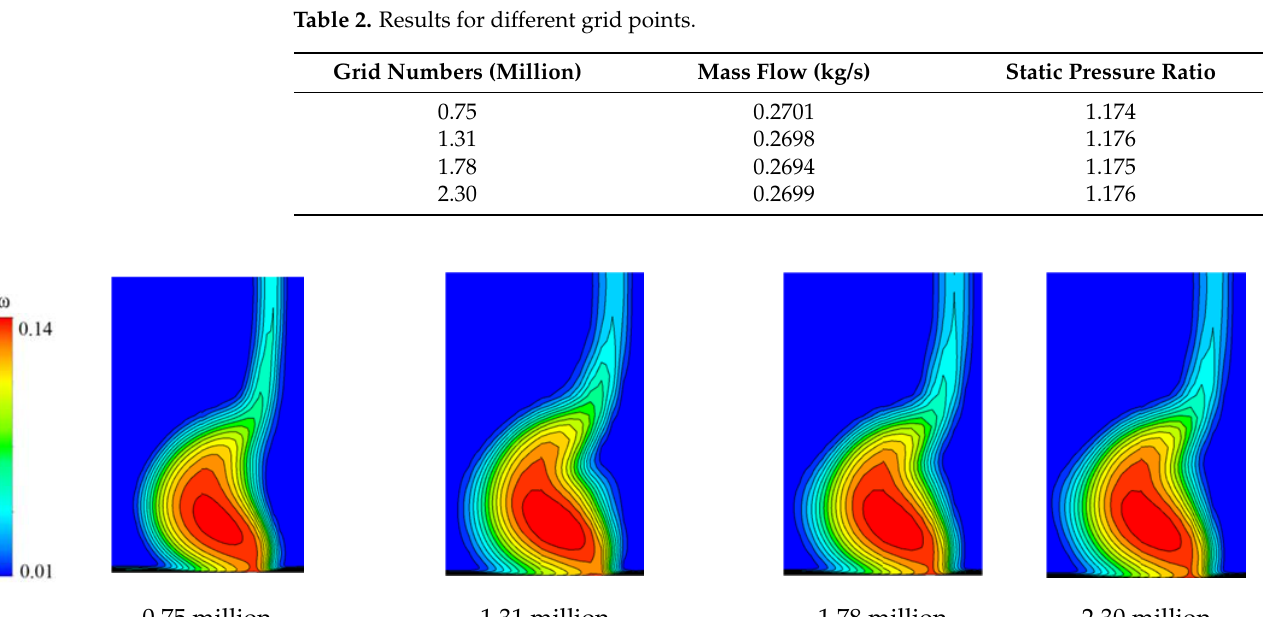
Figure 2. Contour of total pressure loss coefficient at various grid points.